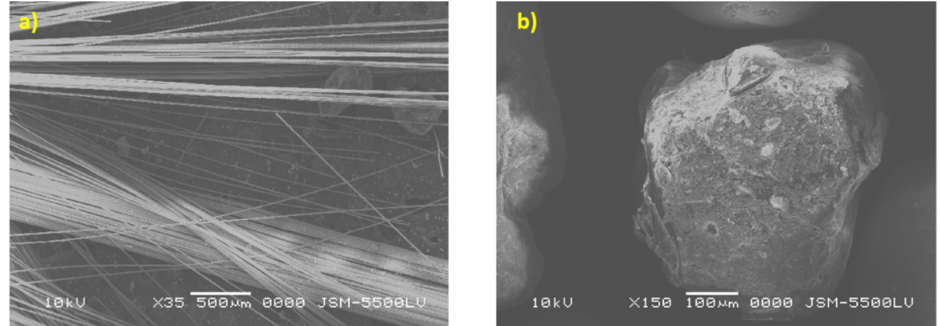
Figure 5. GRP constitutive contents ( a ) fiber shape, ( b ) quartz sand shape and size.